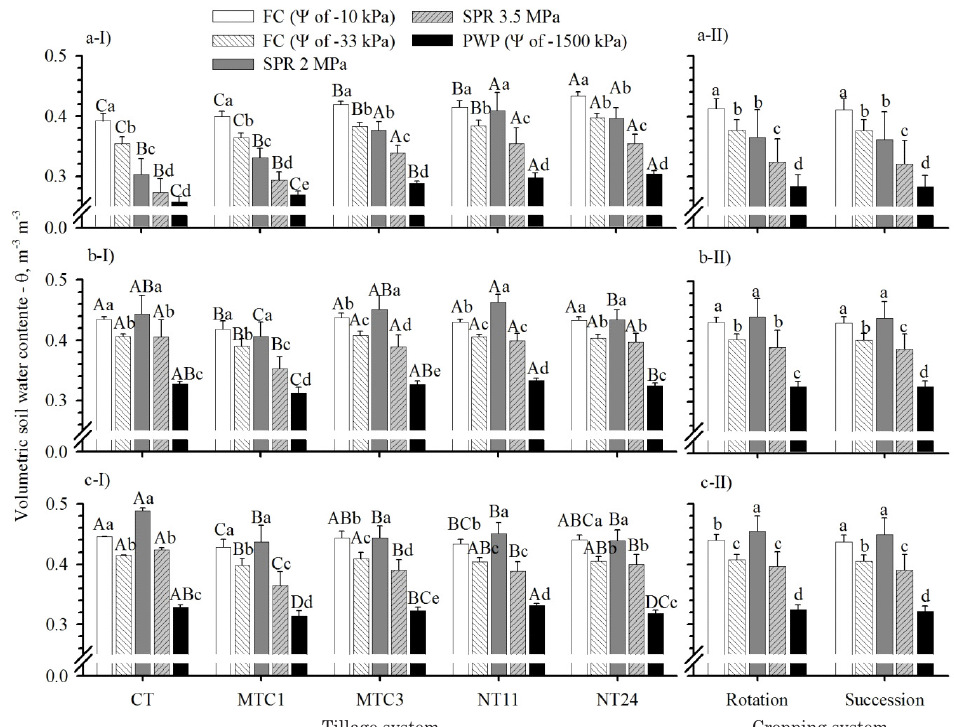
Figure 3. Volumetric water content at field capacity (matric potential of -10 and -33 kPa), permanent wilting point (matric potential of -1500 kPa) limits and soil penetration resistance at 2 and 3.5 MPa, in the 0.0 - 0.10 m (a) 0.10-0.20 m (b) and 0.20-0.30 m (c) layers under different tillage (I) and cropping systems